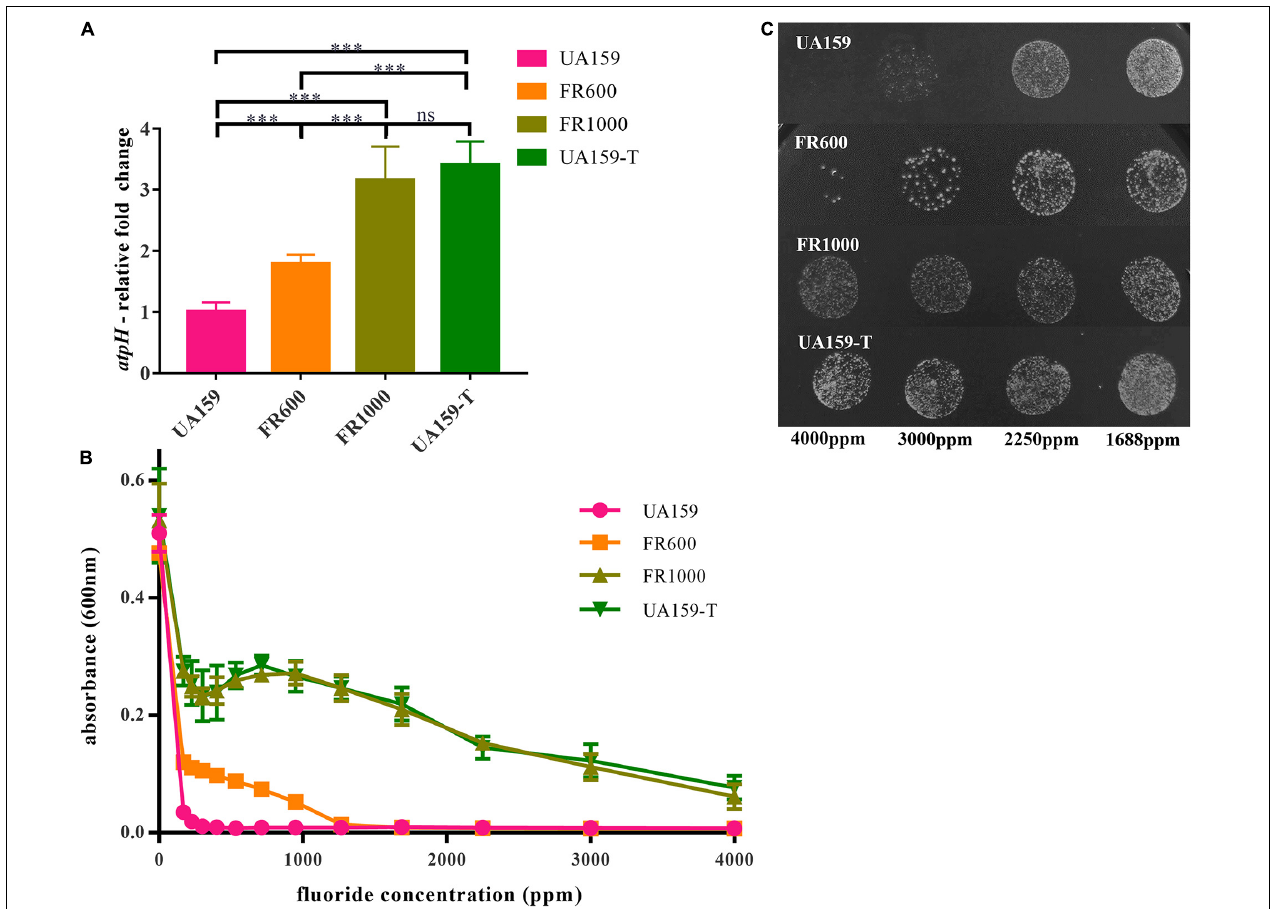
FIGURE 2 | − 36G → T point mutation in UA159-T caused up-regulated atpH gene expression and fluoride resistance. (A) Quantitative real-time PCR of atpH : One -36G → T point mutation in F 0 F 1 -ATPase promoter significantly up-regulated atpH gene expression. Overall expression compared to UA159 was presented as average fold change ± SD. The significance level ( α ) was set at 0.05 (One-way ANOVA, Dunnett’s T3, IBeleM SPSS Statistics 24). *** indicates P < 0.001. ns indicates no significant difference. N = 12 per group. (B) Effects of gradient-concentration fluoride treatment on S. mutans growth: One -36G → T point mutation in F 0 F 1 -ATPase promoter significantly increased fluoride resistance. 1:100 diluted overnight suspension of strains was incubated in 96-well culture plates with different concentrations of fluoride (3/4-fold serial) for 24 h. N = 12 per group and per fluoride concentration. (C) Effects of gradient-concentration fluoride treatment on Colony-Forming Units of S. mutans : FR1000 and UA159-T showed higher fluoride tolerance than UA159. Five microliter suspension of the UA159, FR1000, UA159-T from the 96-well culture plate of MIC assays (treated with 3/4-fold serial dilutions of fluoride for 24 h) was incubated on TSA for 2 days. Images were taken by a